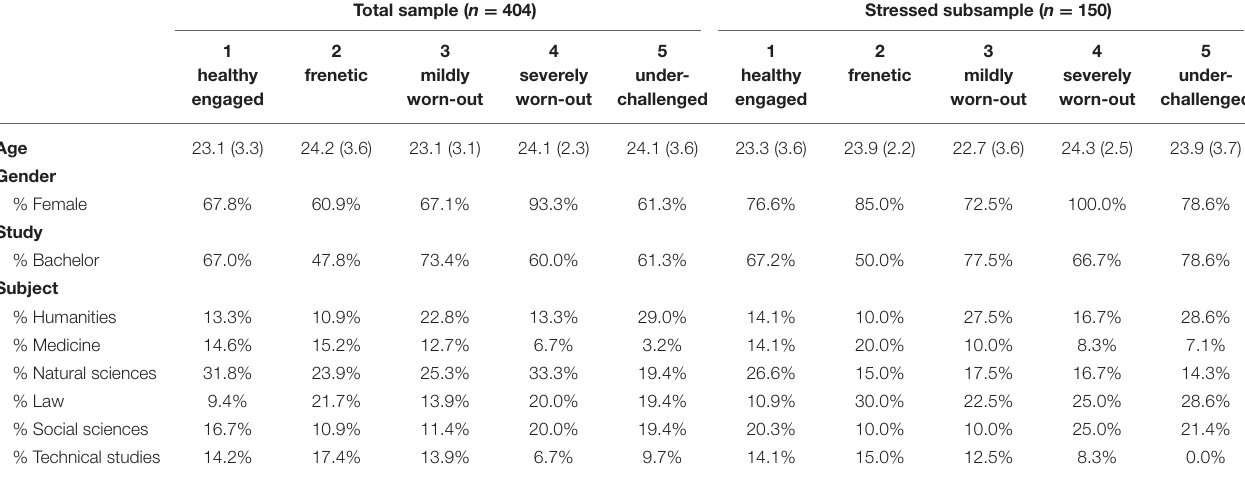
TABLE 6 | Sociodemographic and additional study characteristics of the five BCSQ-12-SS classes. Total sample ( n =